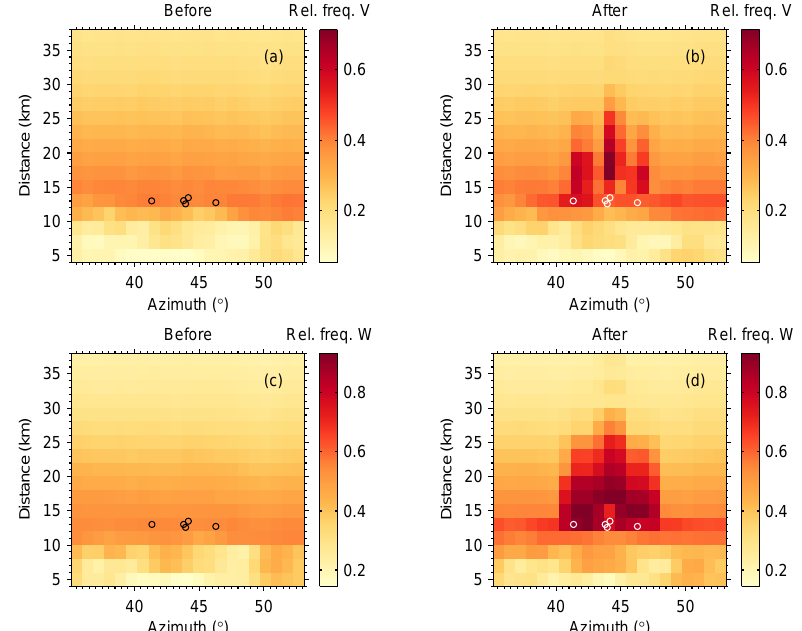
Figure 3. Relative frequency of real (detected and valid) measurements of radial velocity, V , and spectrum width, W , before and after the construction of the Brunsmo wind farm. The locations of the wind turbines are shown with black or white circles. The wind turbines are seen to increase the frequency of real measurements of V and W , both at the location of the wind turbines as well as cross- and downrange from the wind